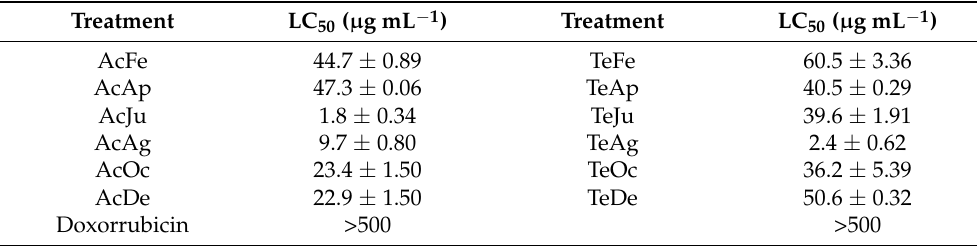
Table 4. Brine shrimp lethality of the extracts from A. muricata leaves.